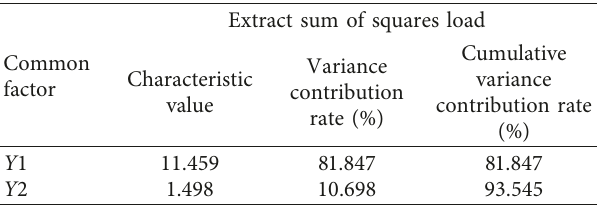
Table 3: Interpretation of total variance.